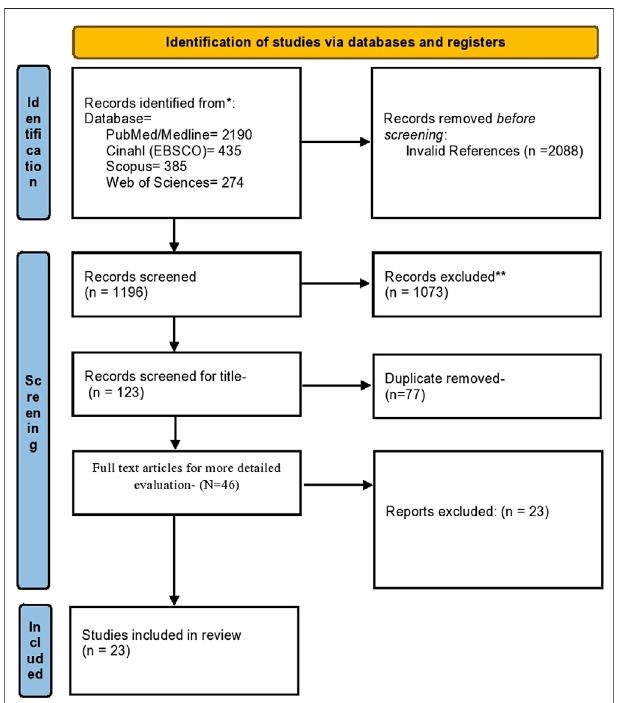
FIGURE 1 | Flow chart for identi fi cation and inclusion of studies in the meta-analysis (PRISMA statement).